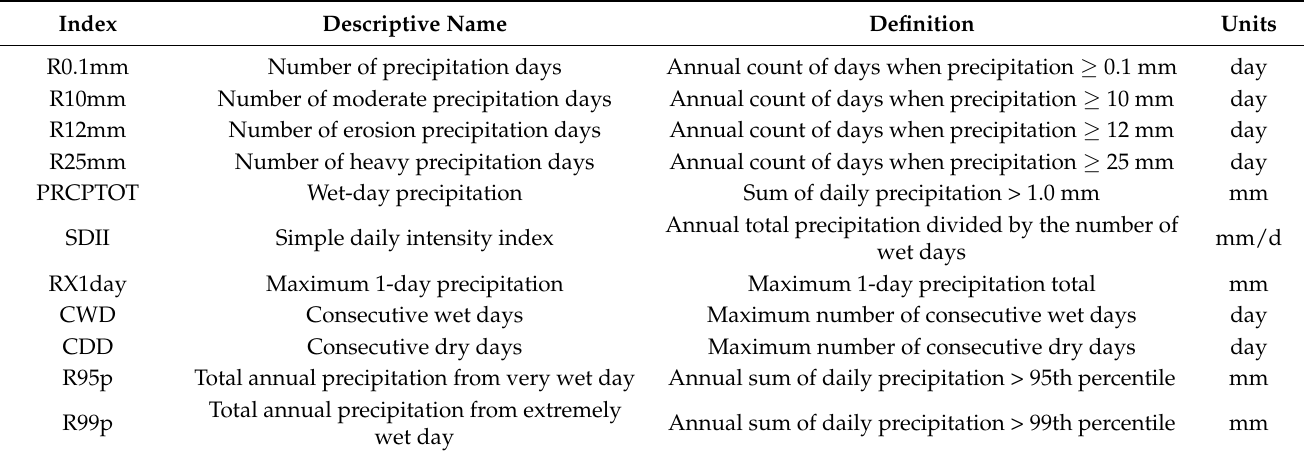
Table 2. Extreme precipitation indices used in this